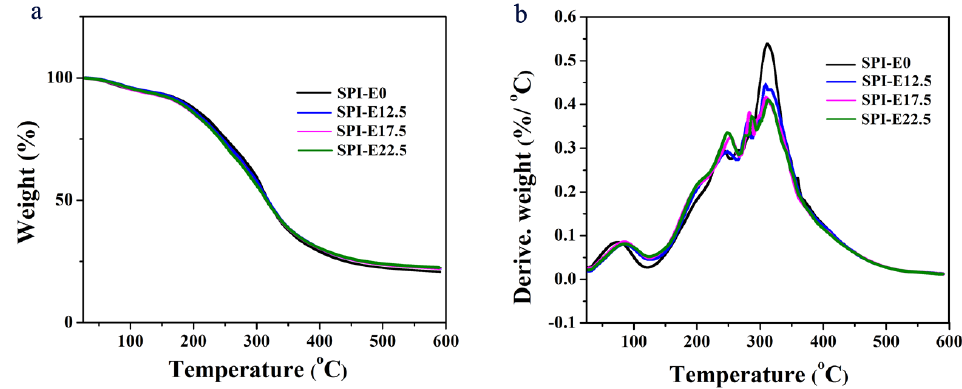
Figure 4. ( a ) Thermogravimetric analysis (TGA) and ( b ) differential thermogravimetric analysis (DTG) curves of the SPI-based films.